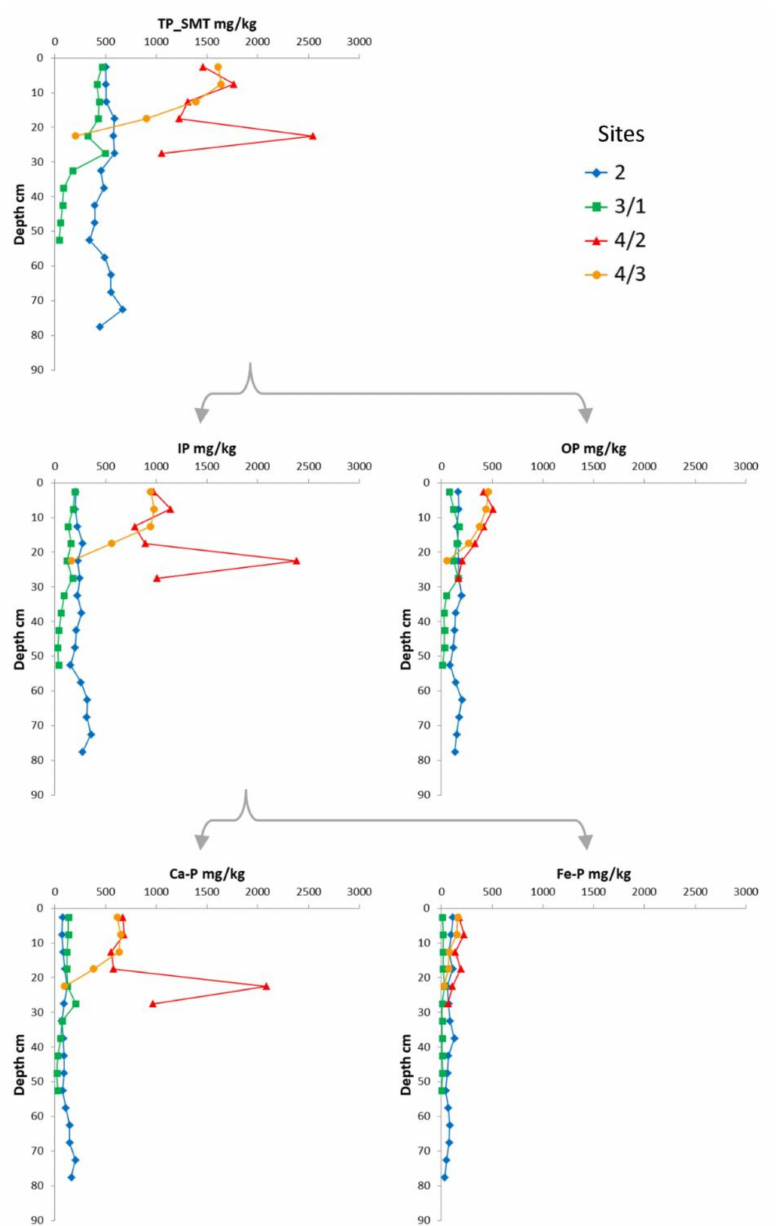
Figure 3. TP SMT and P forms determined from core sediment samples and their variation with